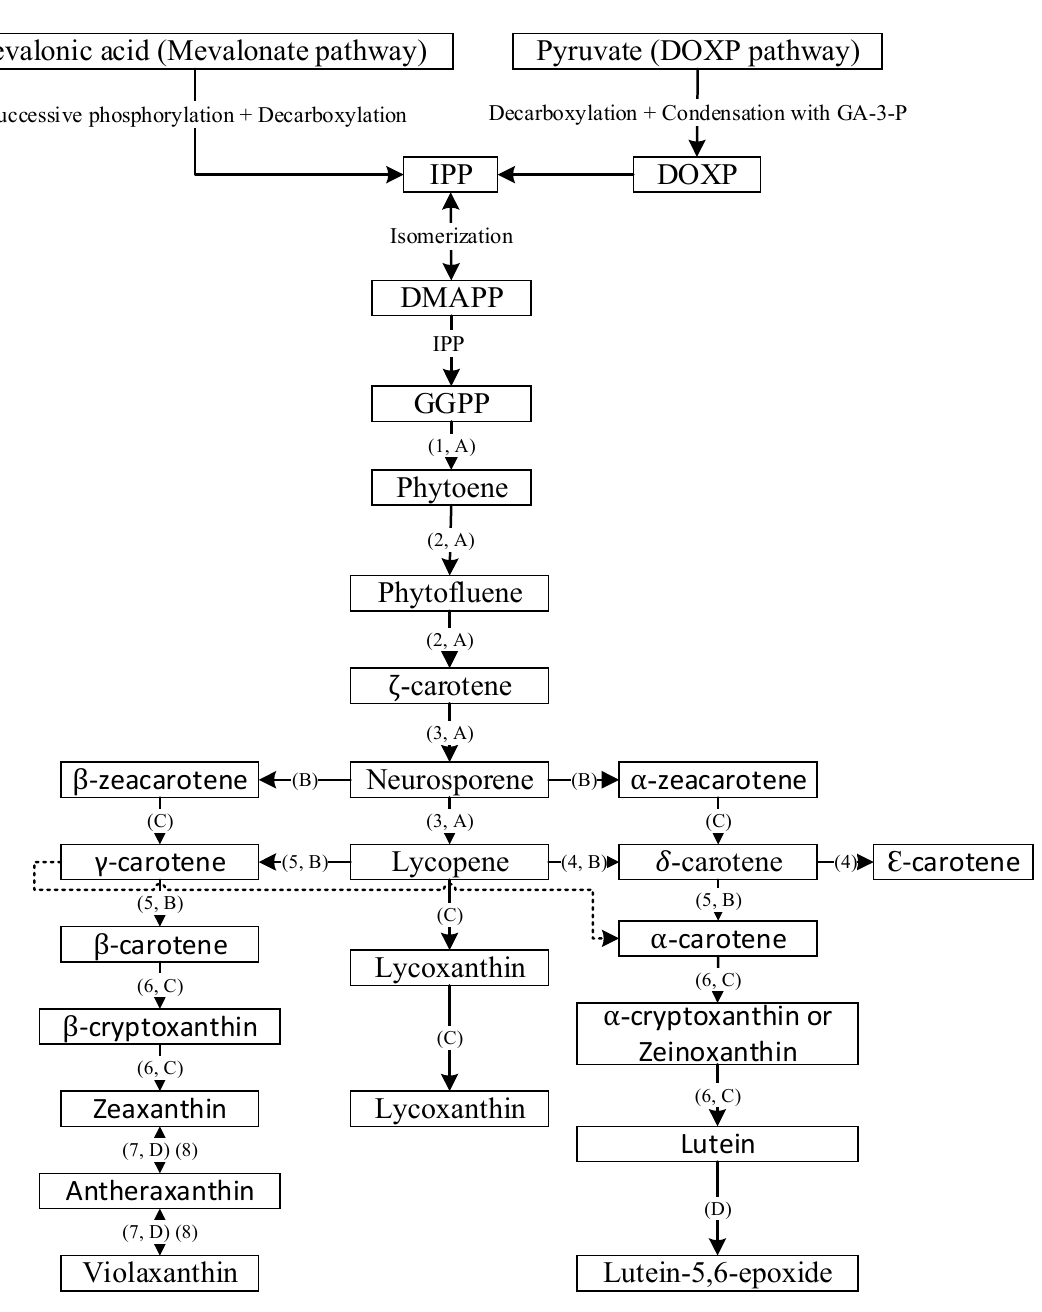
Figure 2. General overview of carotenoid biosynthesis pathway. DOXP = 1-deoxy-D-xylulose, GA-3-P = glyceraldehyde 3-phosphate, IPP = isopentyl diphosphate, DMAPP = dimethylallyl diphosphate and GGPP = geranylgeranyl pyrophosphate; 1 = phytoene synthase, 2 = phytoene desaturase, 3 = ζ -carotene desaturase, 4 = lycopene e-cyclase, 5 = lycopene β -cyclase; 6 = β -carotene hydroxylase, 7 = zeaxanthin epoxidase and 8 = violaxanthin de-epoxidase; A = desaturation, B = cyclization, C = hydroxylation and D = epoxidation.